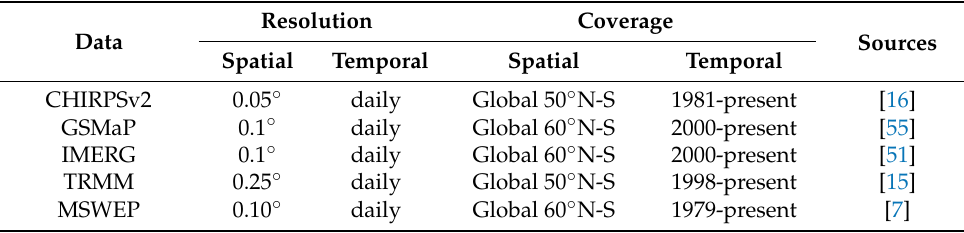
Table 1. Data used in this study from 2003 to 2017.